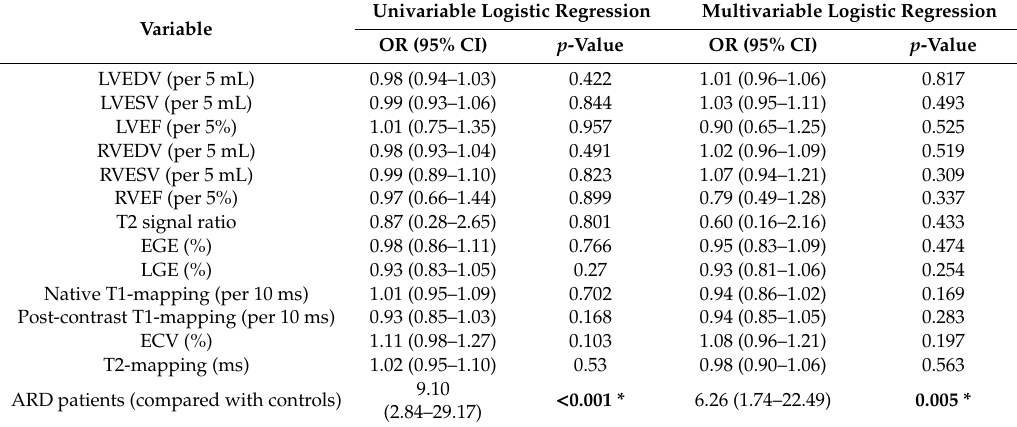
Table 3. Results of univariable and multivariable logistic regression analysis for predicting the presence of any type of brain lesion. Multivariable corrections were applied for age and sex to each index separately. This was a pooled analysis of ARD patients and disease controls with and without brain